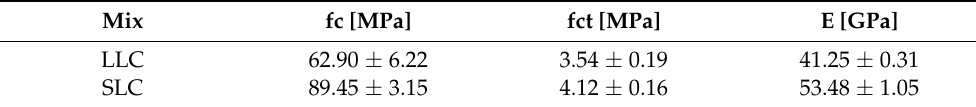
Table 5. Mechanical properties of the mixes